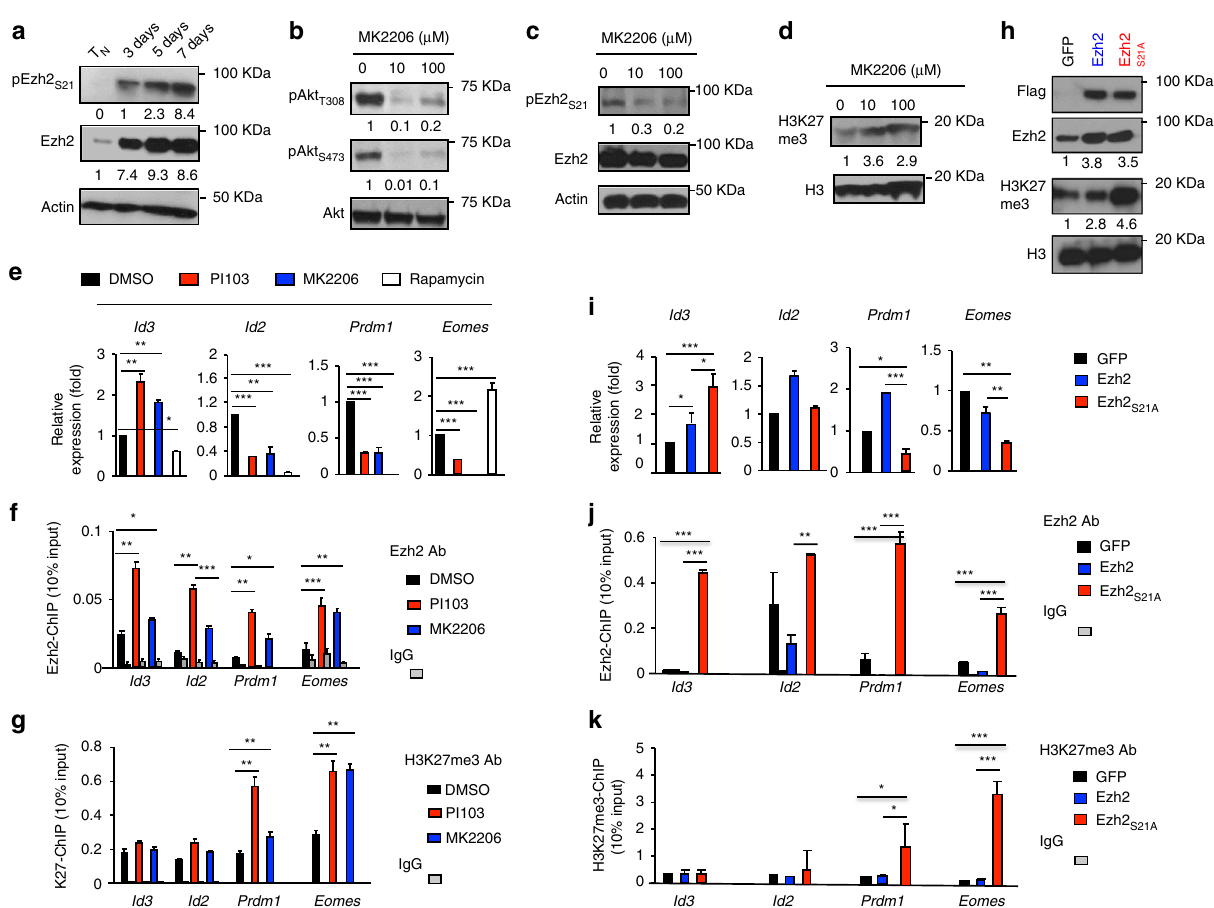
Fig. 5 Phosphorylation of Ezh2 by Akt dissociates Ezh2 from the promoter regions of major TF loci. a WT Pmel-1 cells were stimulated with anti-CD3/ CD28 Ab + IL-2. Immunoblot analysis of Pmel-1 cells stimulated in vitro for 3 days, 5 days, and 7 days, probed with Abs against Ezh2 and